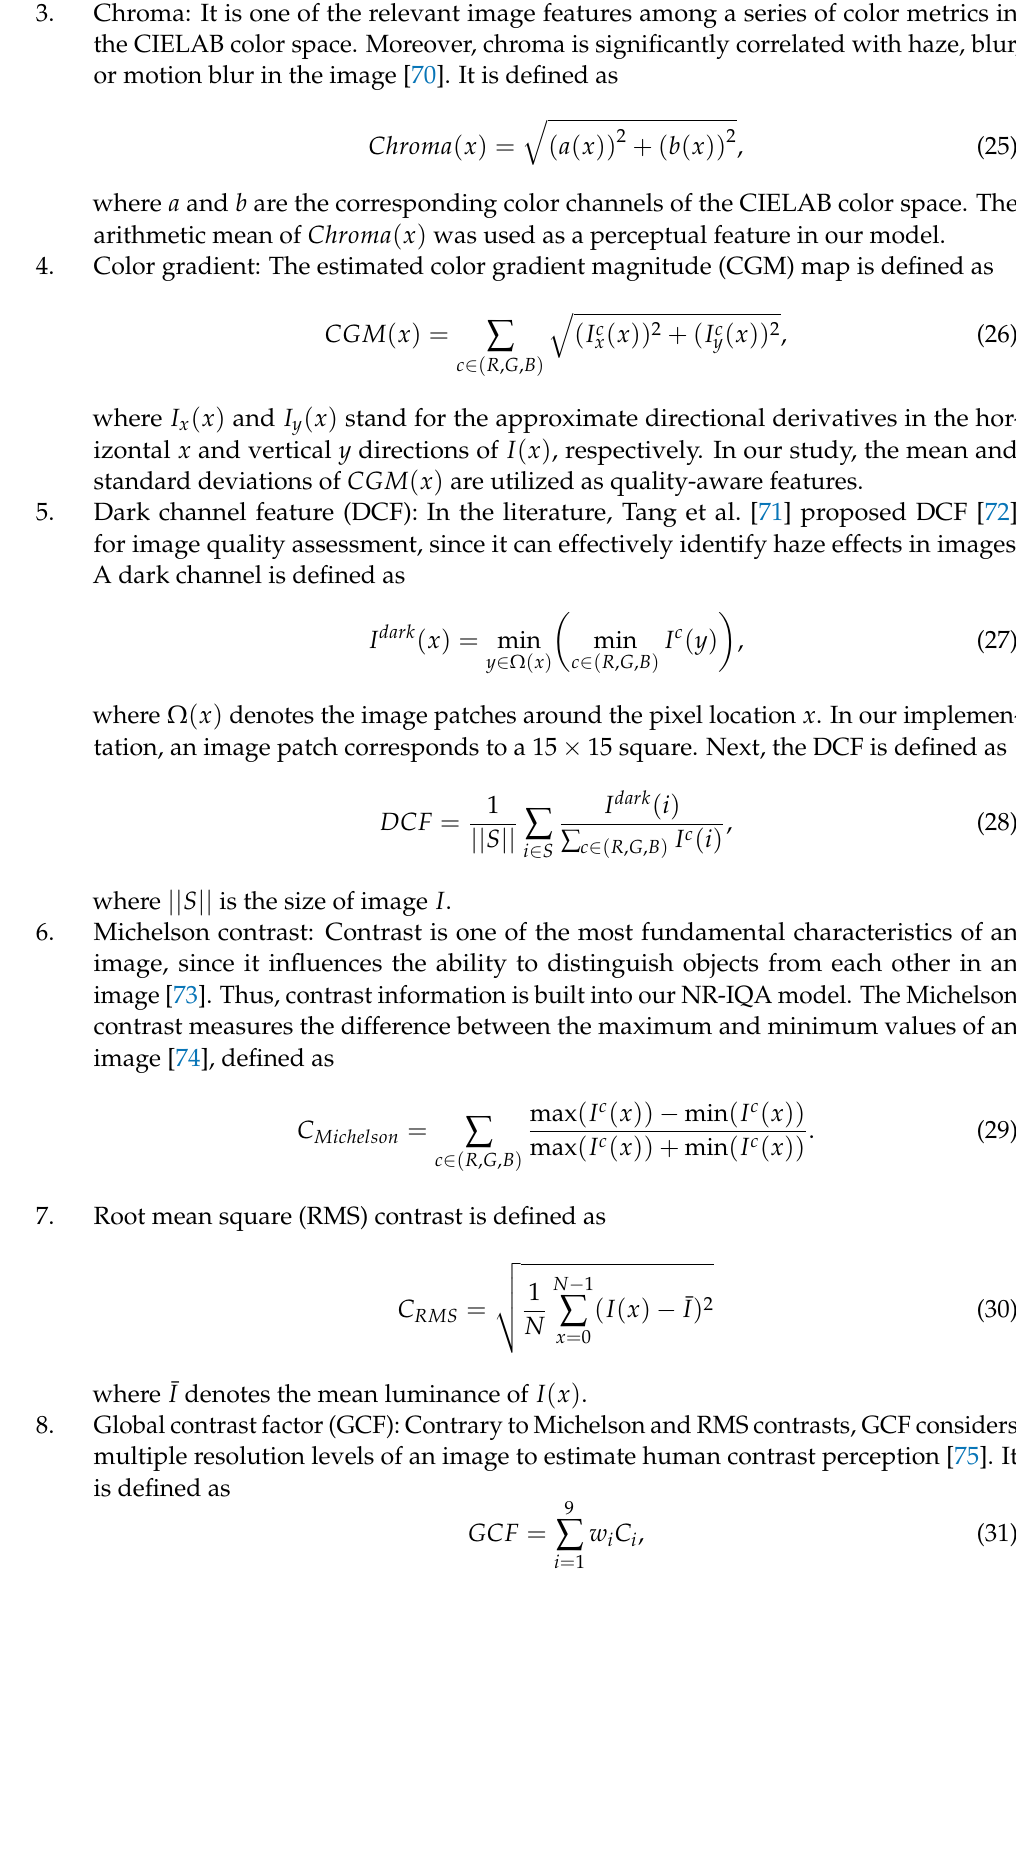
3. Chroma: It is one of the relevant image features among a series of color metrics in the CIELAB color space. Moreover, chroma is significantly correlated with haze, blur, or motion blur in the image [70]. It is defined as